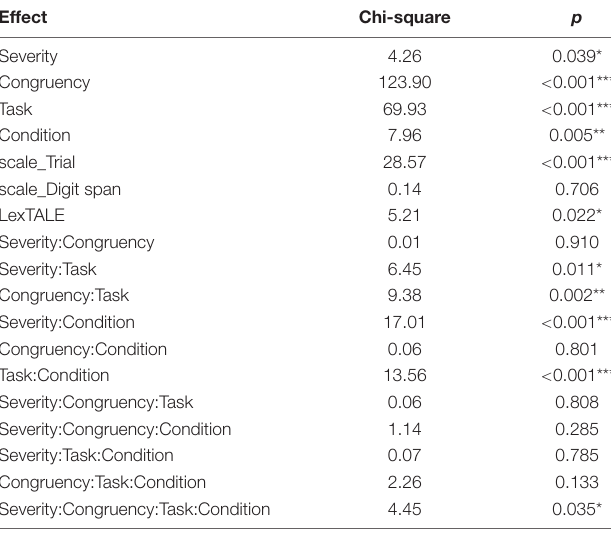
TABLE 3 | Results of linear mixed effects model on reaction time (full presentation with results of both Experiment 1 and Experiment 2). Effect